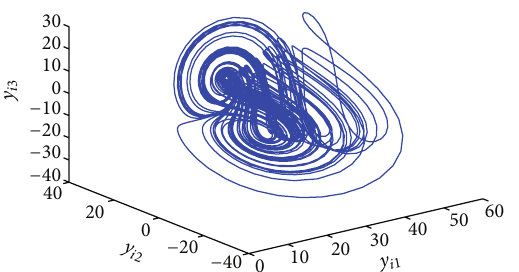
Figure 7: Phase diagram of the Chen attractor for 𝑙 = 35 , 𝑚 = 3 , and 𝑛 = 28 .